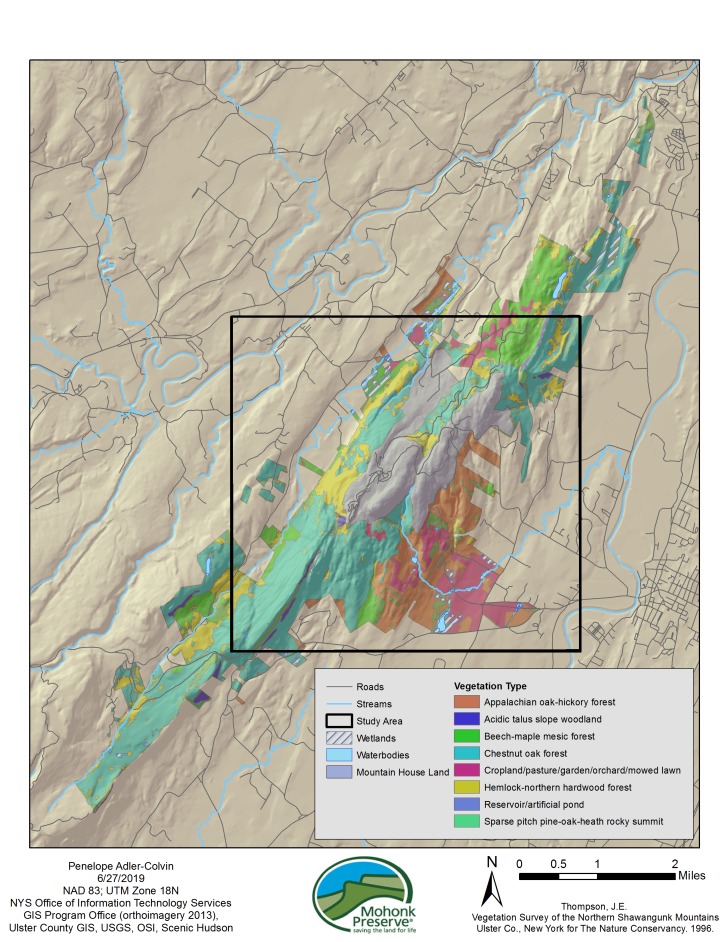
Vegetation cover and geography of the vernal pool data collection region in the Mohonk Preserve. Vegetation cover adapted from Thompson and Huth (2011) and New York State Museum (1999).